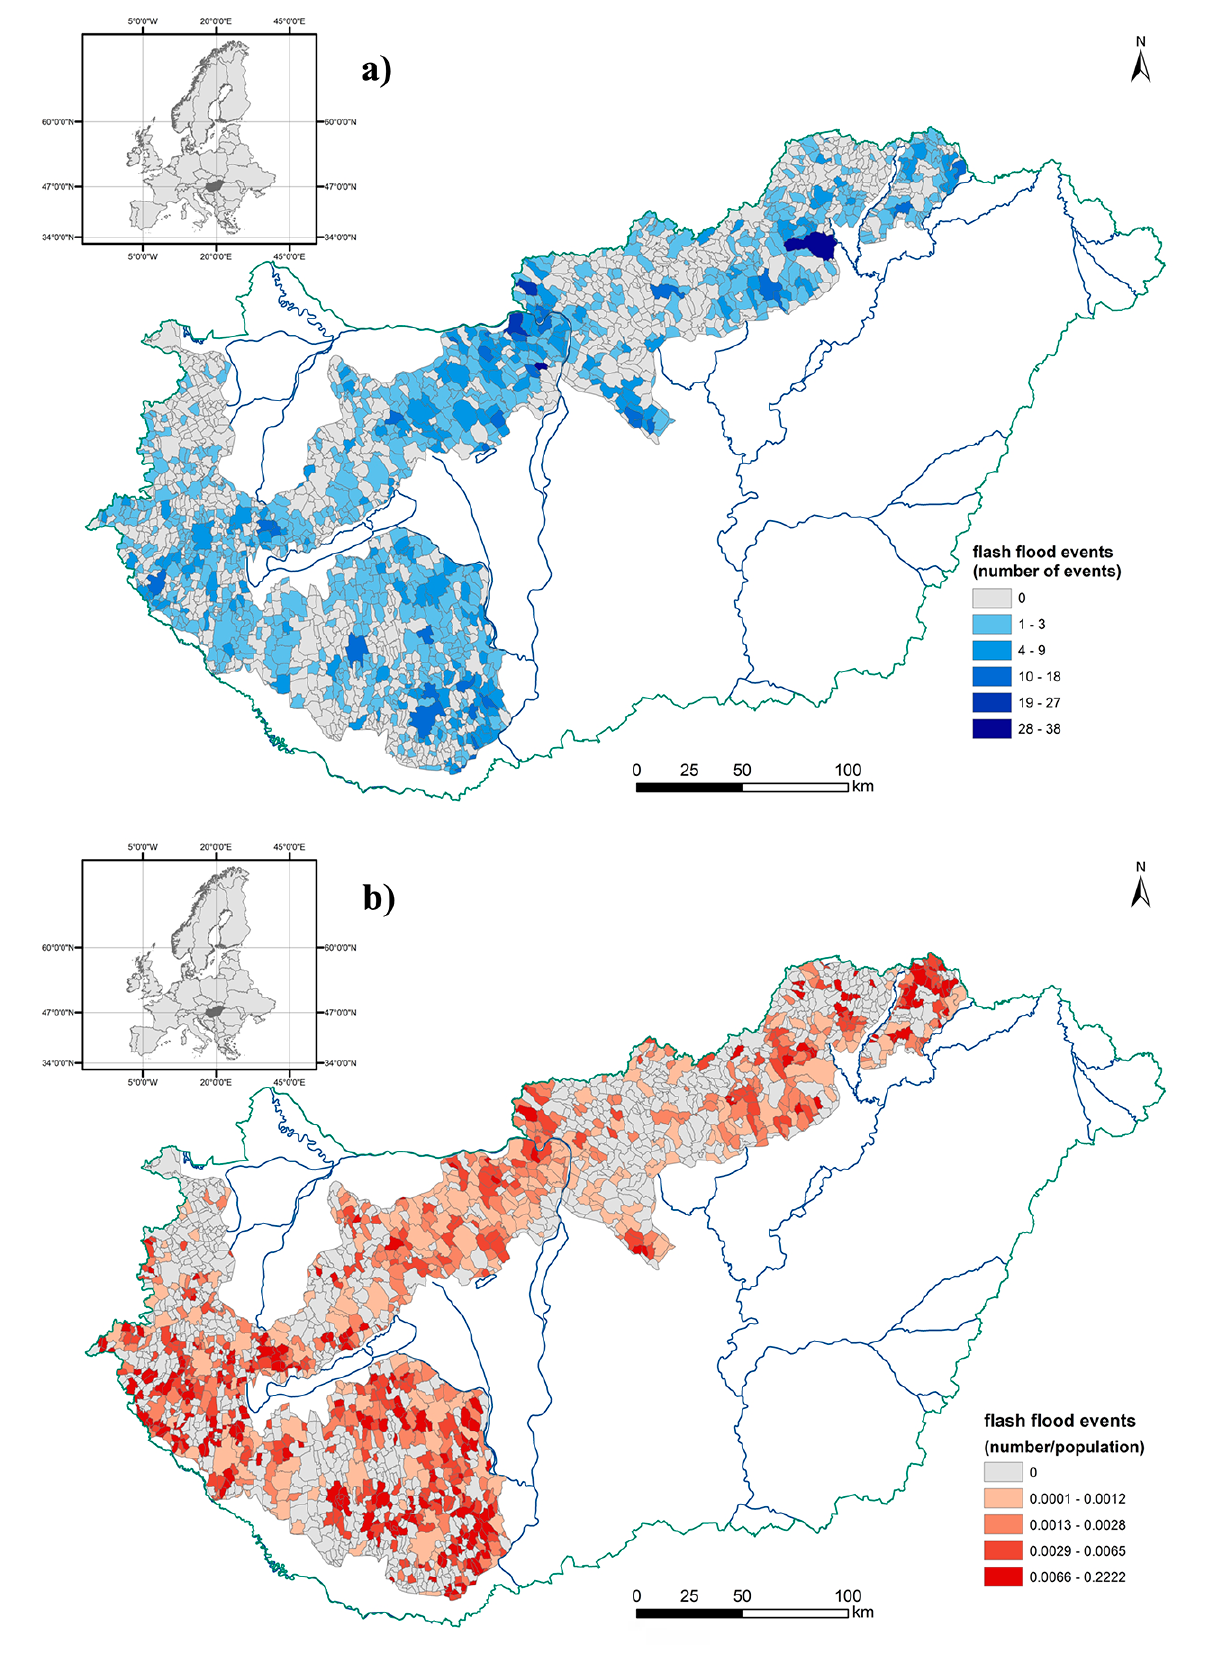
Figure 6. Reported flash flood events (a) and population normalized flash flood events (b) of